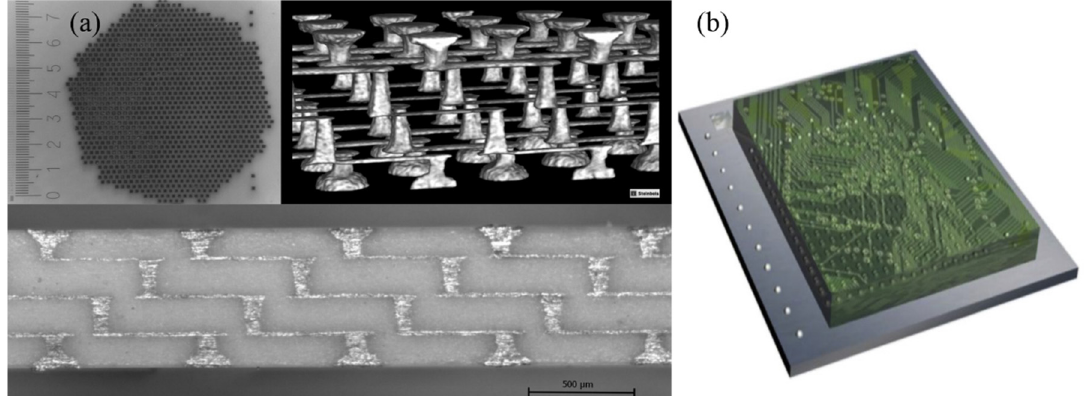
Figure 3. ( a ) The high-density electrode array and corresponding cross-section of hermetic feedthroughs produced with four layers, Reproduced with permission from [44], published by Wiley Online Library, 2014; ( b ) illustration of a high-density array of diamond feedthrough and electrode with 256 channels, Reproduced with permission from [25], published by Elsevier, 2014.